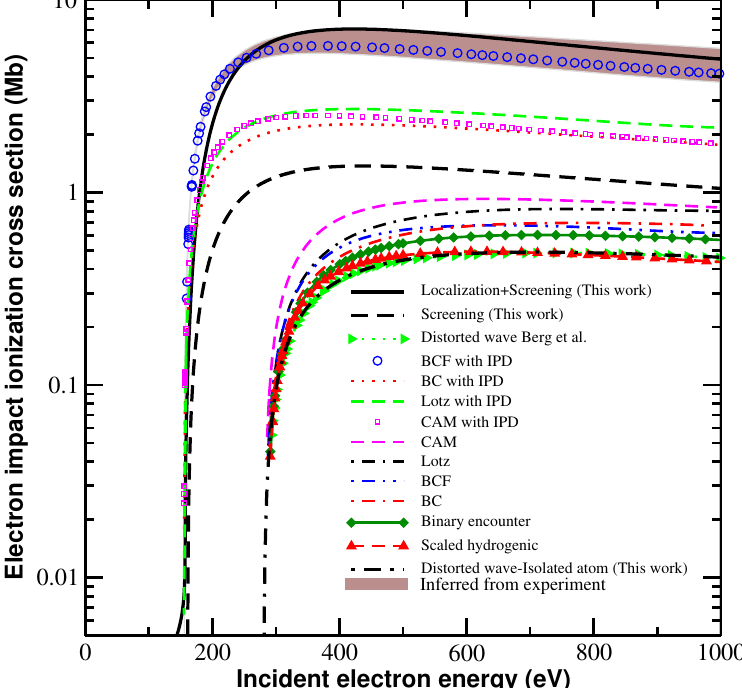
Figure 5. Collisional ionization integral cross section for core-hole state of Mg 7 + 1 s 1 2 s 2 2 p 2 . The electron-impact ionization considered, e + 1 s 2 s 2 2 p 2 2 P 1/2 → 1 s 2 s 2 2 p + 2 e of Mg 7 + , occurs in solid- density magnesium plasma at an electron temperature of 75 eV and a density of 3.0 × 10 23 cm − 3 . The cross sections we obtained are compared with the result inferred from the experiment by Berg et al. [32] and from theoretical calculations using Lotz [41] and the revisions by Burgess and Chidichimo (BC) [42]; the scaled hydrogenic approximation [44] and its analytic fitting formula by Clark, Abdallah,